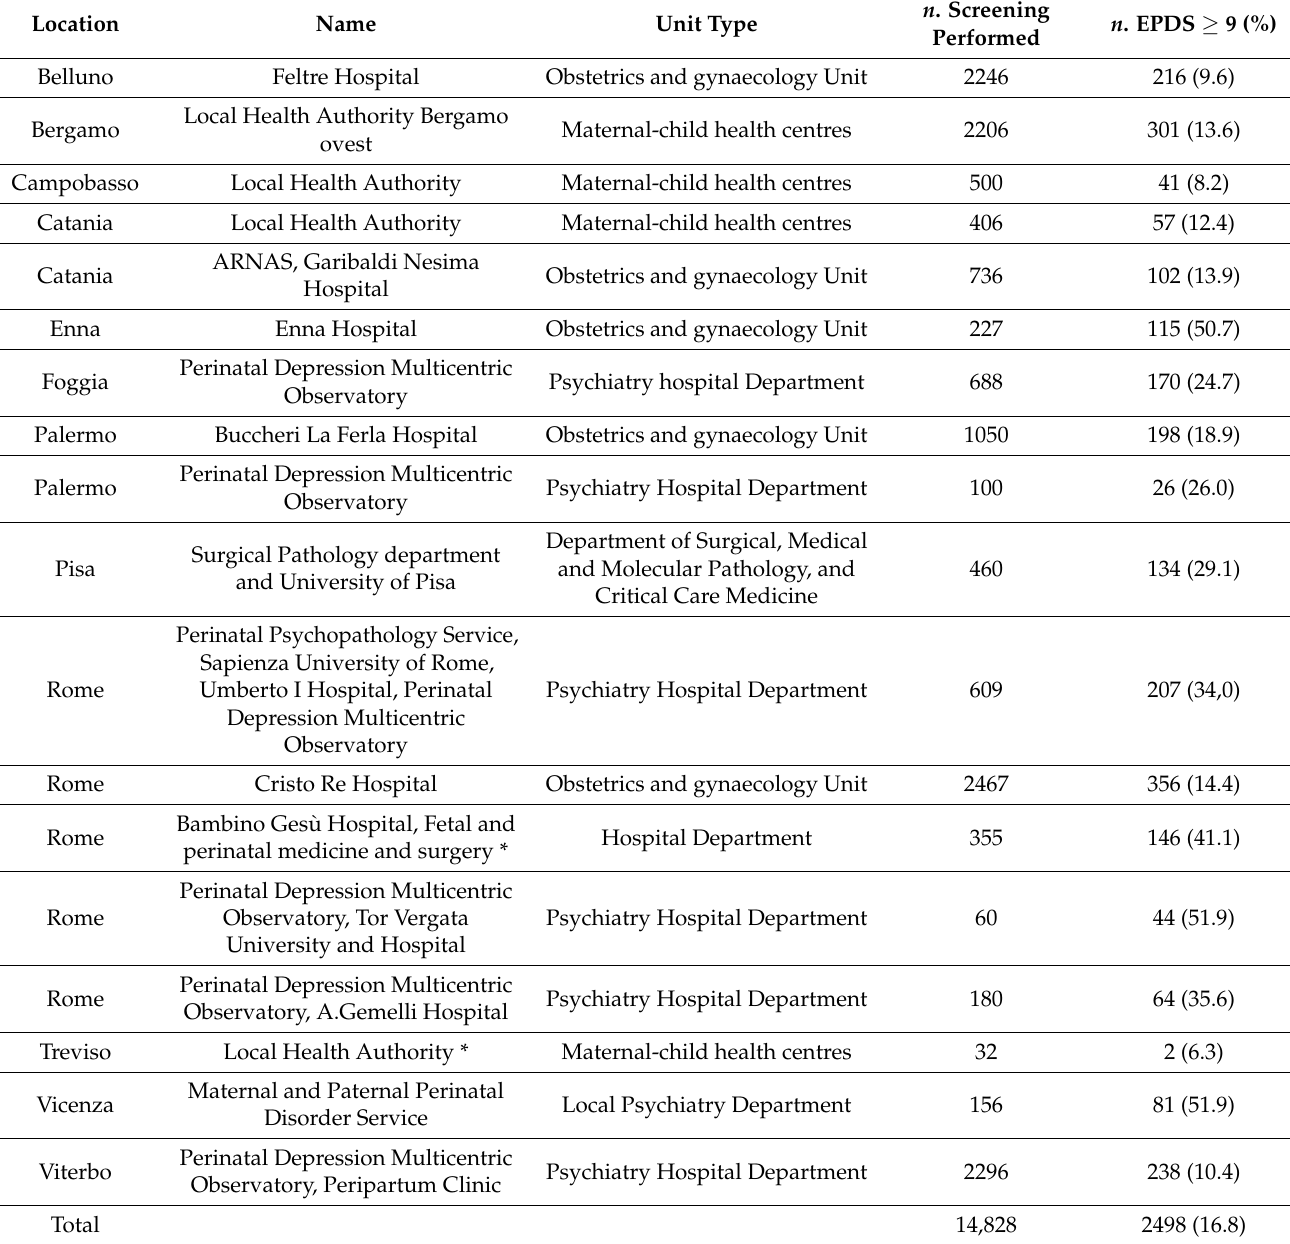
Table 1. Total screening performed, number and percentage of EPDS score ≥ 9 according to the healthcare Centres involved in the study,